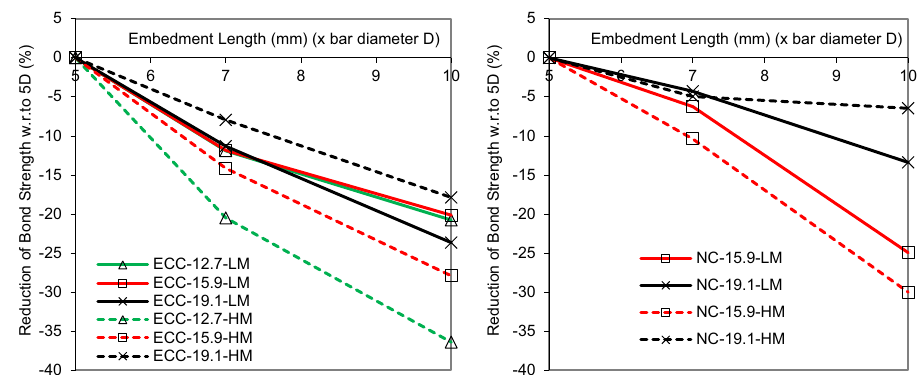
Fig. 10 Reduction of bond strength with embedment